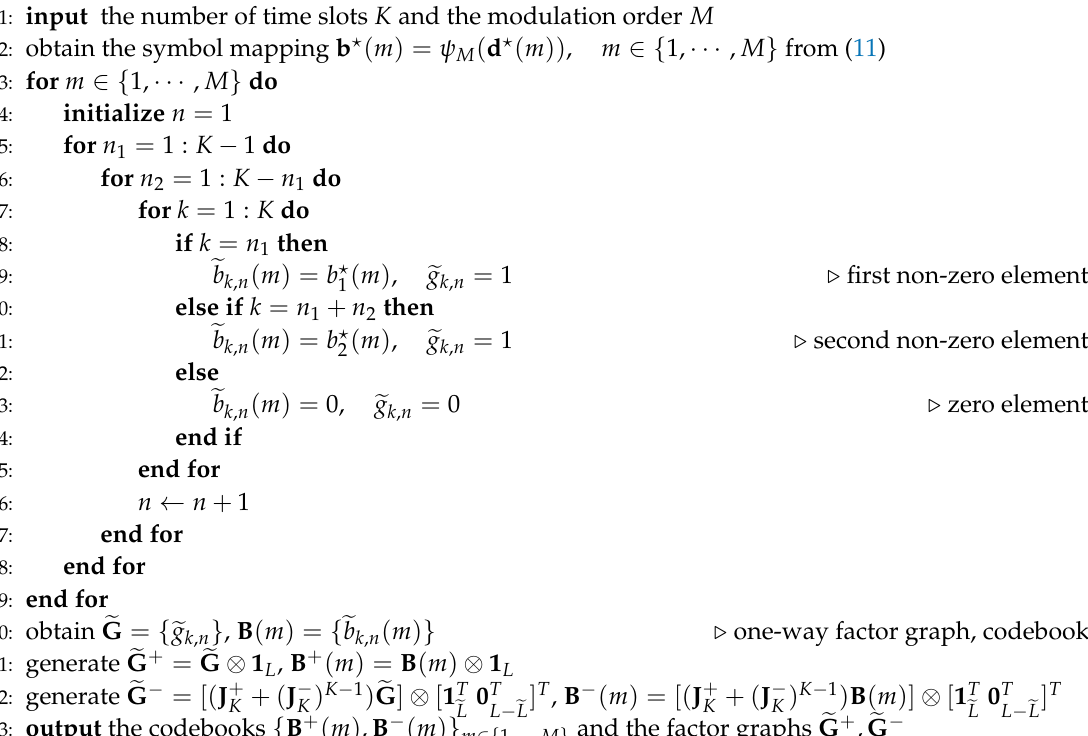
Algorithm 1 Sparse-coded backscatter modulation algorithm